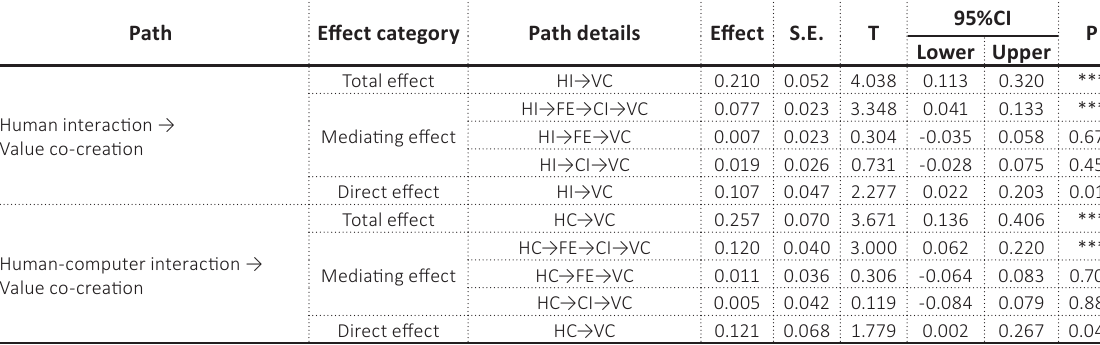
Table 5. Test results of mediating effect